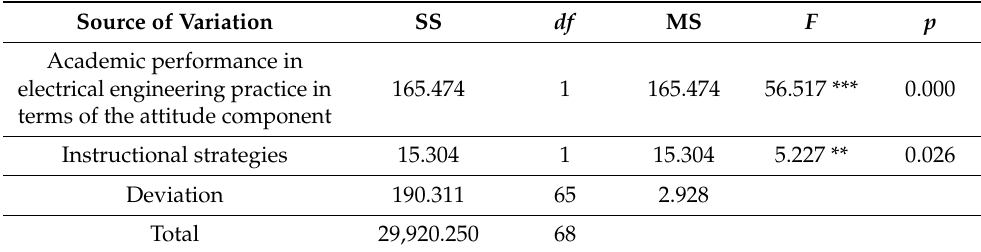
Table 19. Recapitulation sheet of analysis of covariance in basic electricity practical overall learning effectiveness in terms of the attitude component.